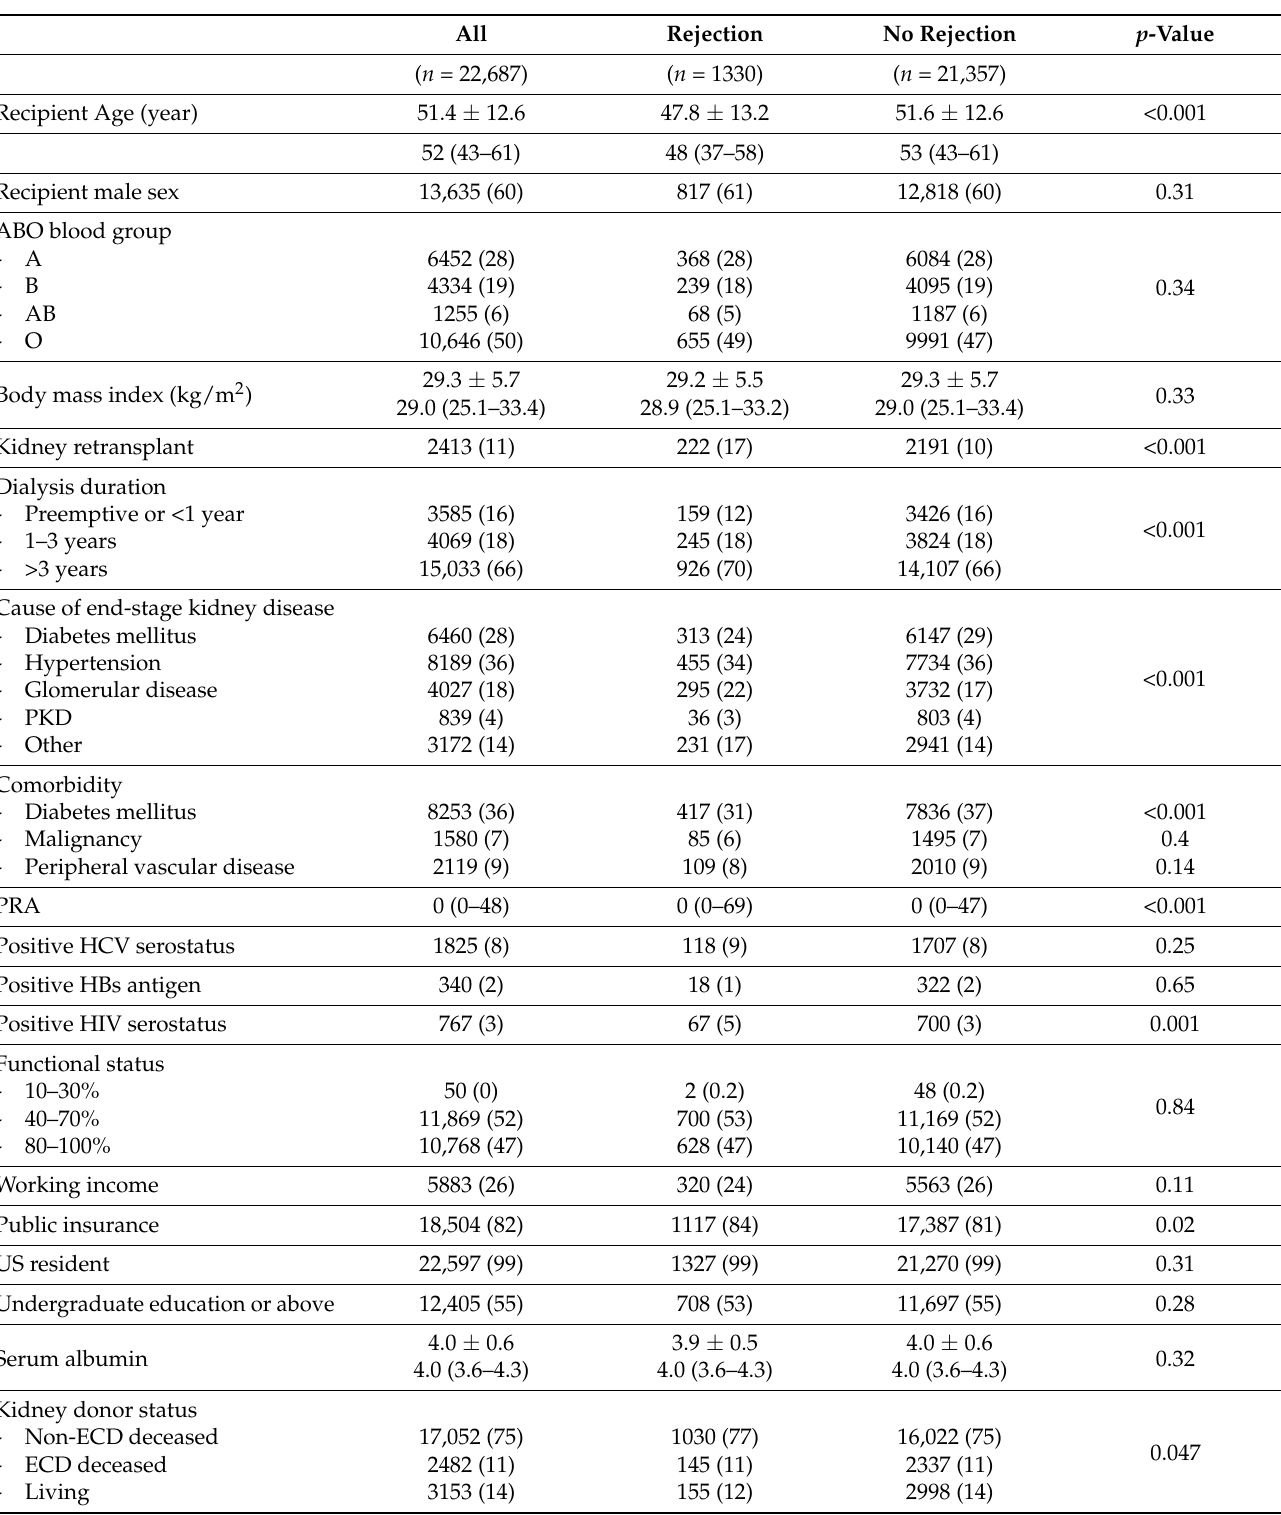
Table 1. Clinical characteristics between kidney transplant recipients with and without